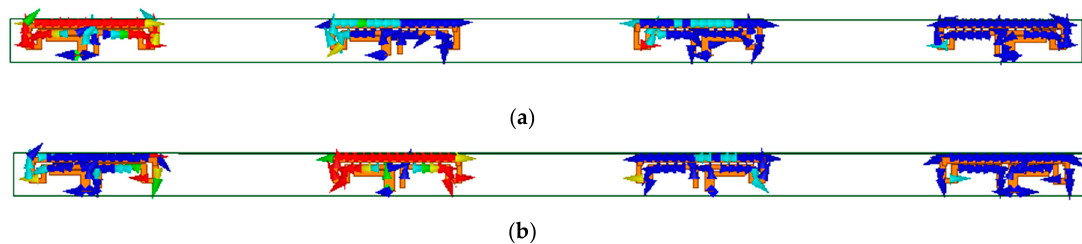
Figure 12. Simulated current distribution at 3.5 GHz of the proposed MIMO antenna array. ( a ) ant 1 excited; ( b ) ant 2 excited.